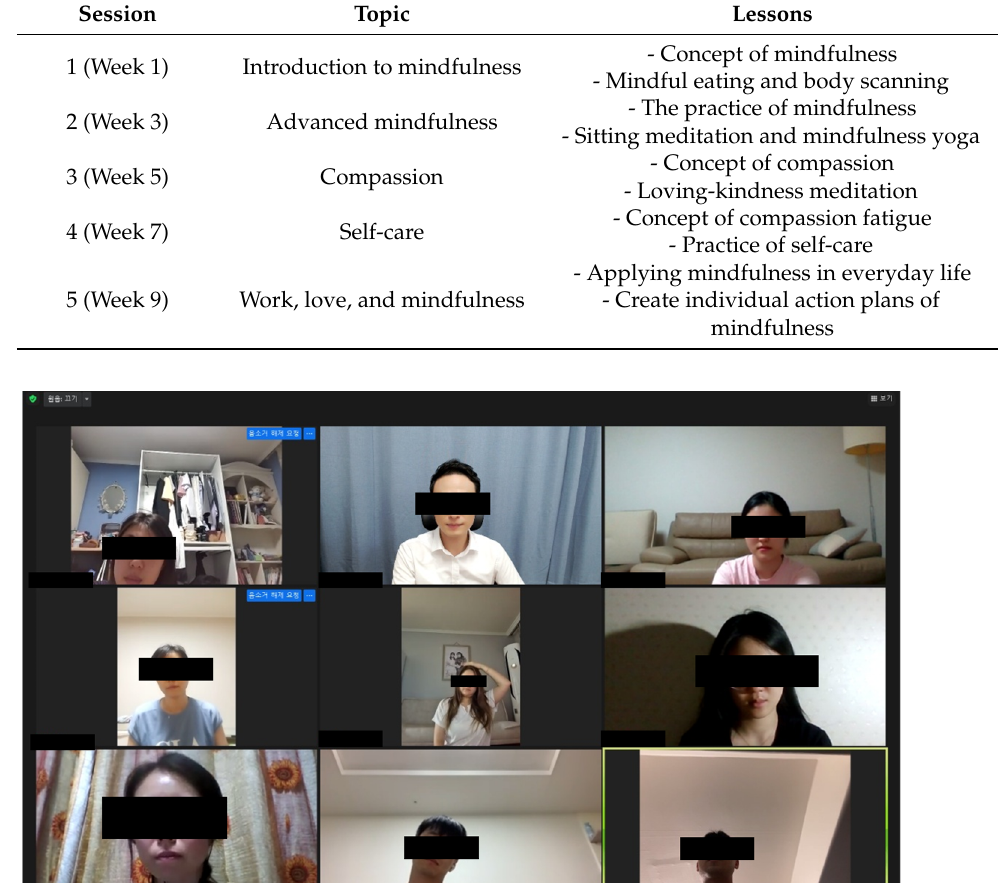
Table 1. Mindfulness program for the participants.